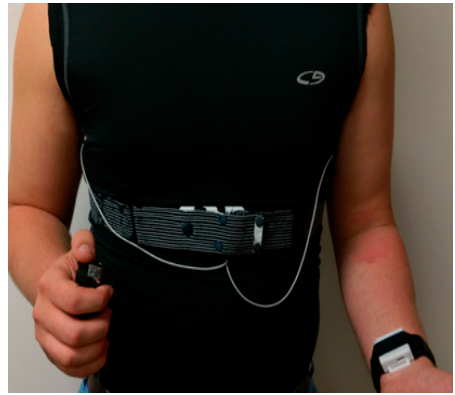
Figure 14. Personal Automatic Cigarette Tracker v2 (PACT2.0) applied on a male subject: chest module attached with the belt, hand module placed on the dominant hand of smoking and lighter on the non-dominant hand.